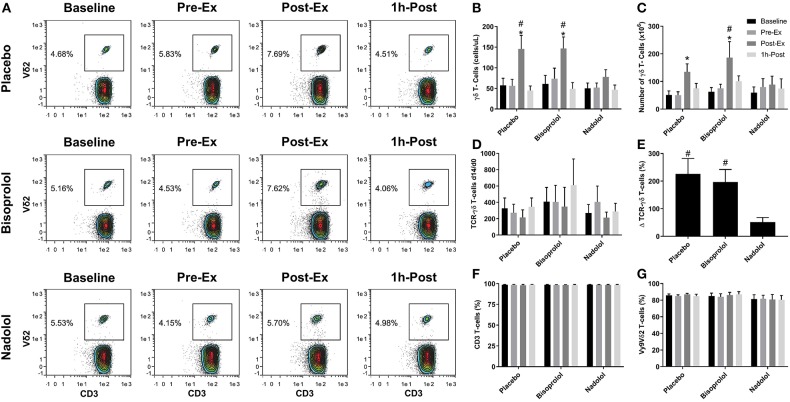
β1 + β2-AR but not β1-AR blockade alone inhibits the mobilization and augmented ex vivo expansion of Vγ9δ2 T-cells in response to exercise. (A) Representative flow cytometry contour plots showing the effects of a β1 + β2-AR antagonist (nadolol) and a β1-AR antagonist (bisoprolol) on the mobilization of Vγ9δ2 T-cells with exercise. Values shown are the percentage of all CD3+ T-cells. (B) The total numbers of TCR-γδ T-cells in blood before and after exercise. After 14 days' expansion with ZOL+IL-2, (C) the total number, (D) the number of TCR-γδ cells generated at Day 14 divided by the number of TCR -γδ cells in the PBMC fractions at Day 0 and (E), percentage change in number of TCR-γδ T-cells expanded Post-Ex relative to baseline. The percentage of (F) CD3+ and (G) Vγ9Vδ2+ T-cells among the expanded cell products are shown. Values are mean ± SE (n = 6). Significant difference from Baseline/Pre-Ex/1 h-Post and the nadolol trial indicated by * and #, respectively (p < 0.05).